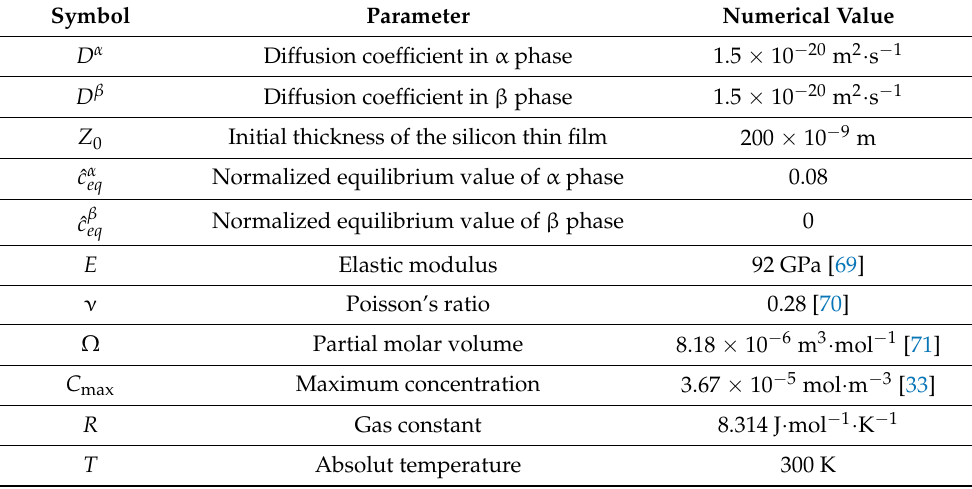
Table 1. Material properties and parameters used in the numerical